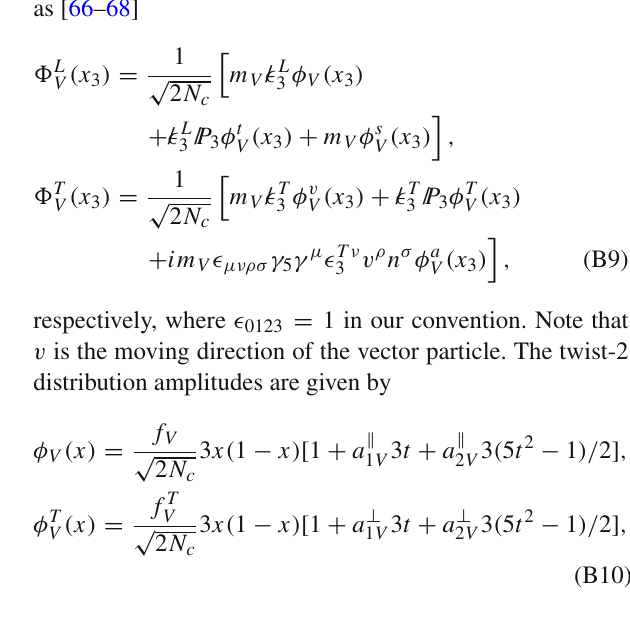
Table 6 Input values of the decay constants and the Gegenbauer moments [75] of the light vector mesons